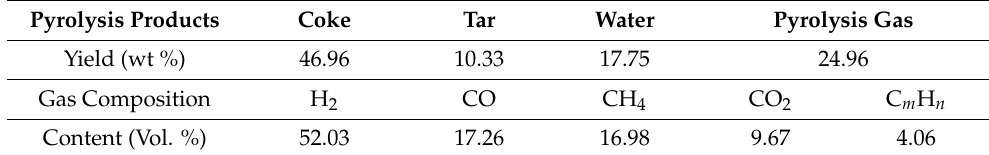
Table 3. The pyrolysis product yield and composition of pyrolysis gas.